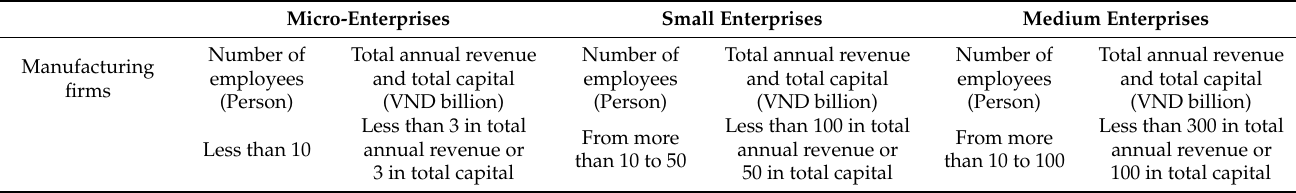
Table 1. Small and medium manufacturing enterprise (SME)